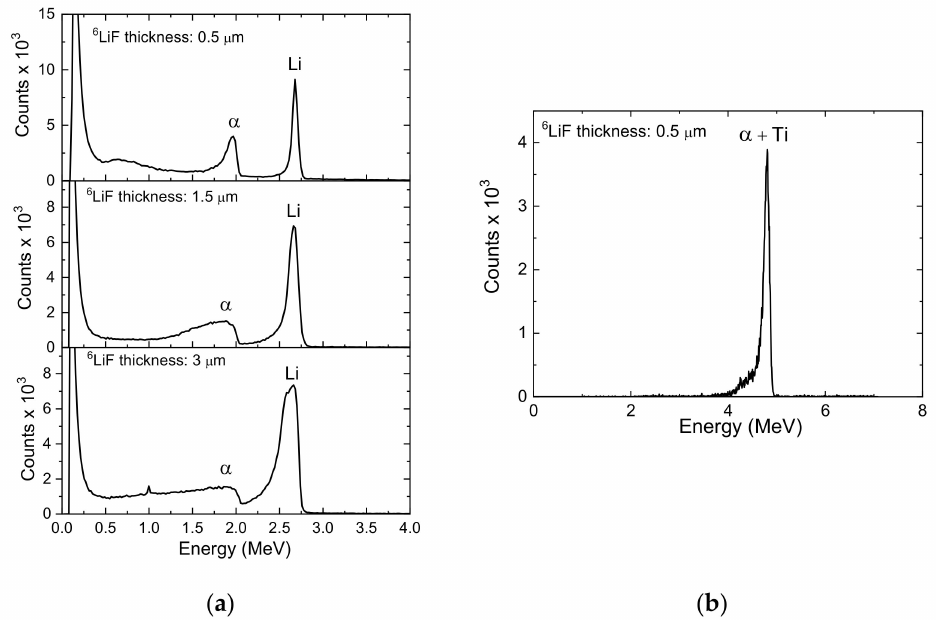
Figure 18. ( a ) Typical α -T peaks PHS recorded with LiDia detectors as a function of the 6 LiF layer thickness; ( b ) Typical α -T peaks PHS recorded with LiDia detectors in “sandwich”